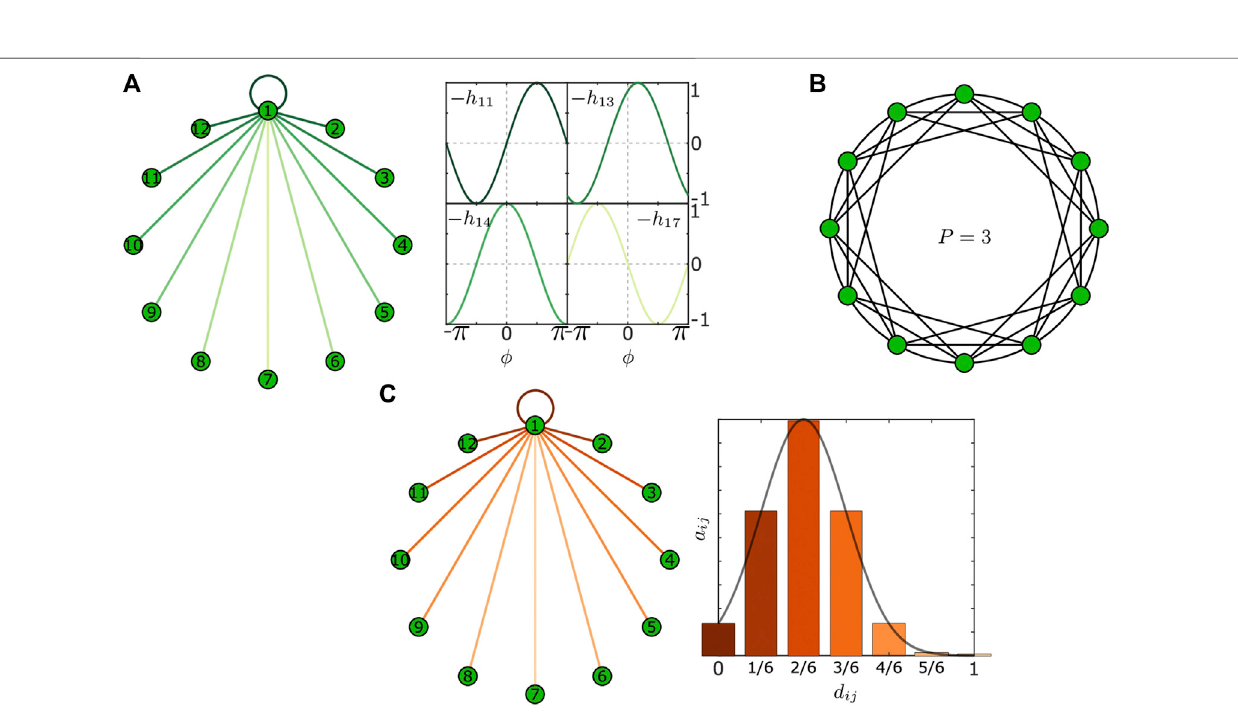
FIGURE2| Panel (A) showstheplasticityfunction h 1 j givenin Eqs.18 – 20 dependingonthedistance d 1 j exempli fi edfornode i (cid:1) 1inanetworkwith N (cid:1) 12nodes. Note that the colors of the links in the network (left) correspond to the colors of the depicted plasticity function (right). Panel (B) displays the connectivity structure of a nonlocally coupled ring network with N (cid:1) 12 nodes and a coupling range P (cid:1) 3. Panel (C) displays the weighted connectivity structure of a network with N (cid:1) 12 nodes (left) with distance-dependent Gaussian weight distribution (right) . Note that the colors of the links in the network (left) correspond to the colors of the bars in the weight distribution (right)